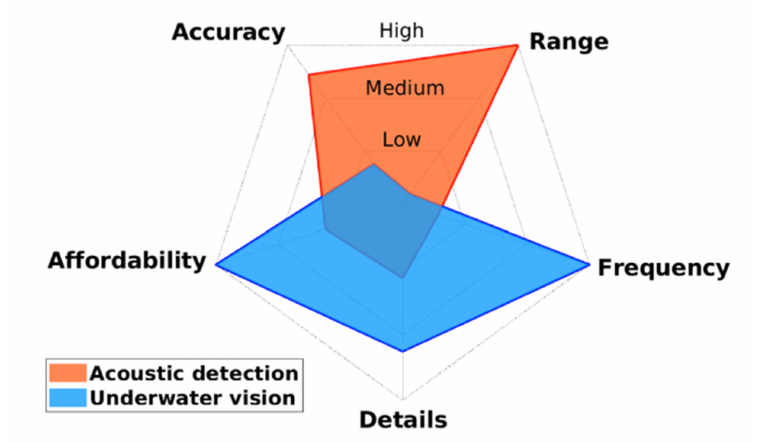
Figure 15. Comparison between acoustic detection and underwater vision